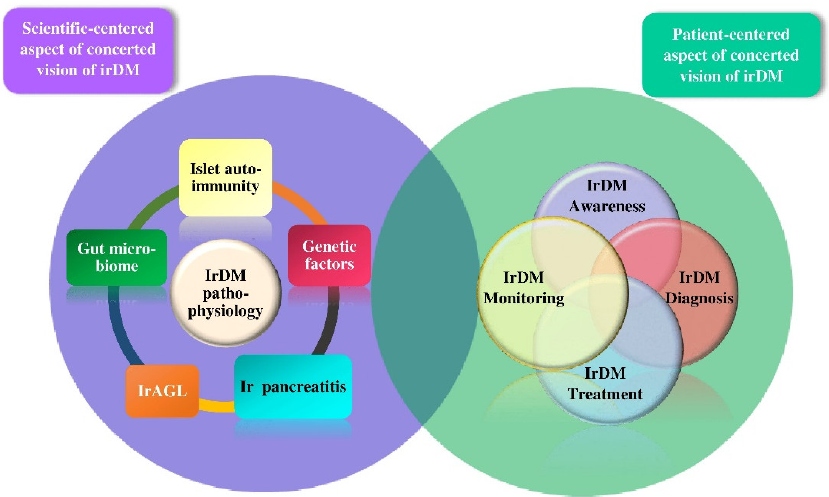
Figure 6. The concerted vision to advance the knowledge of irDM integrating 2 intertwined aspects: a scientific-centered and a patient-centered aspect. Abbreviations: irAGL, immune-related acquired generalized lipodystrophy; irDM, immune-related diabetes mellitus.